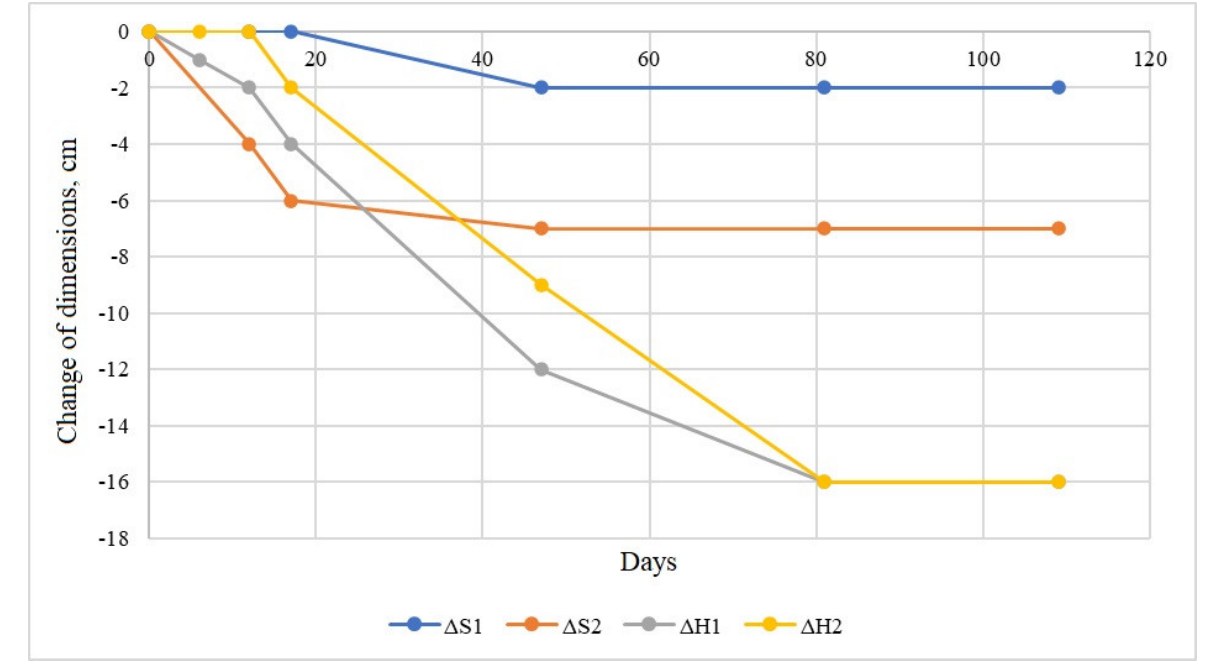
Figure A7. Change of the roadway dimensions—convergence control station no. 3.